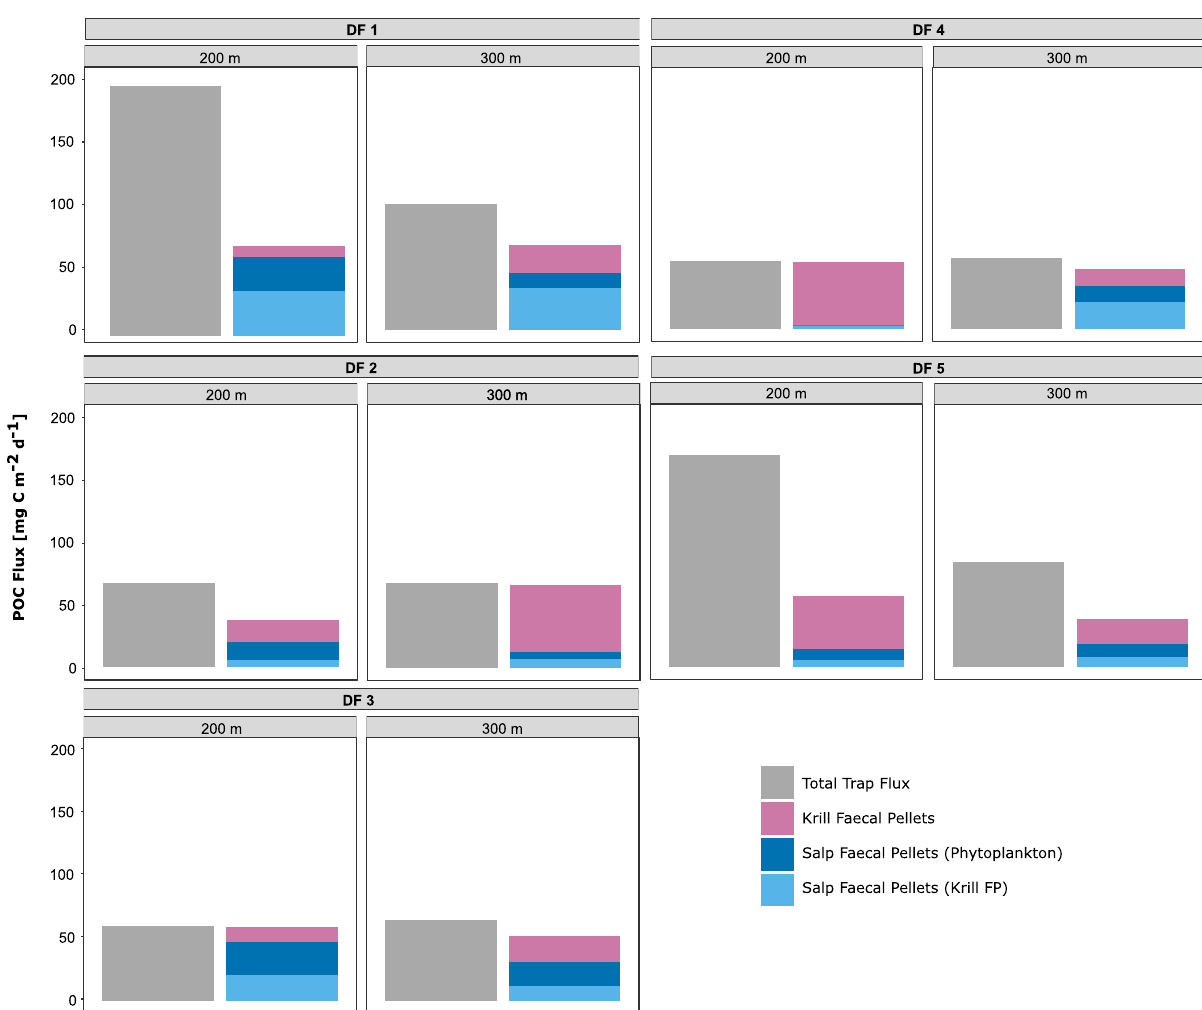
Fig. 1 Flux of particulate organic carbon (POC) in the drifting traps. The fl ux of POC is shown in mg C m − 2 d − 1 . The panels depict the POC fl ux for the fi ve drifting traps (DF 1 to 5) deployed at 200 and 300 m, respectively for 24 h each. The total POC fl ux is depicted in grey, and the respective fl ux of faecal pellets (FP) is shown in pink for krill FP, in dark blue for salp FP consisting of phytoplankton, and in light blue for salp FP consisting of ingested krill